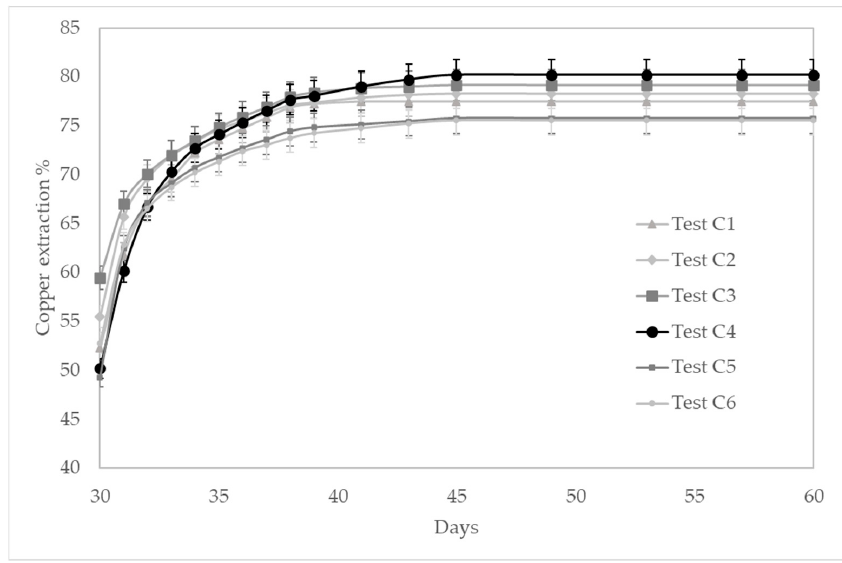
Figure 5. Copper extraction kinetics in tests C.